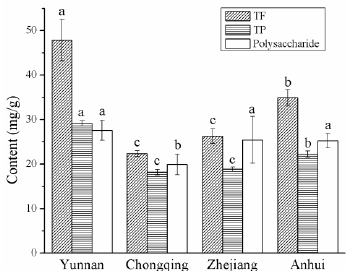
Figure 1. TF, TP and polysaccharide contents of the dried fruits of C. speciosa from four production areas in China. Results are shown as mean ± SD ( n = 3). Different letters above each bar indicate significant differences ( p < 0.05). TF, total flavonoid; TP, total polyphenol.